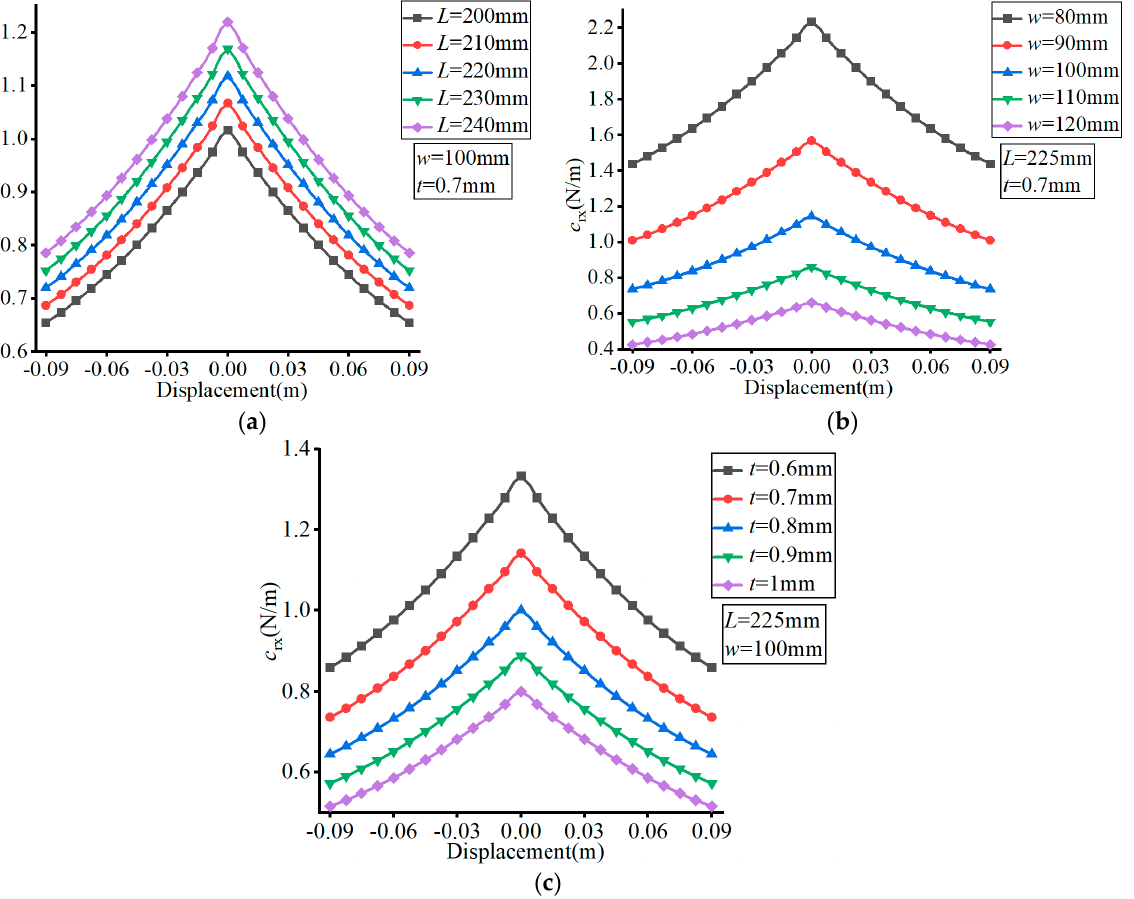
Figure 8. Effect of structural parameters on c rx . ( a ) Effect of L ; ( b ) Effect of w ; ( c ) Effect of t .